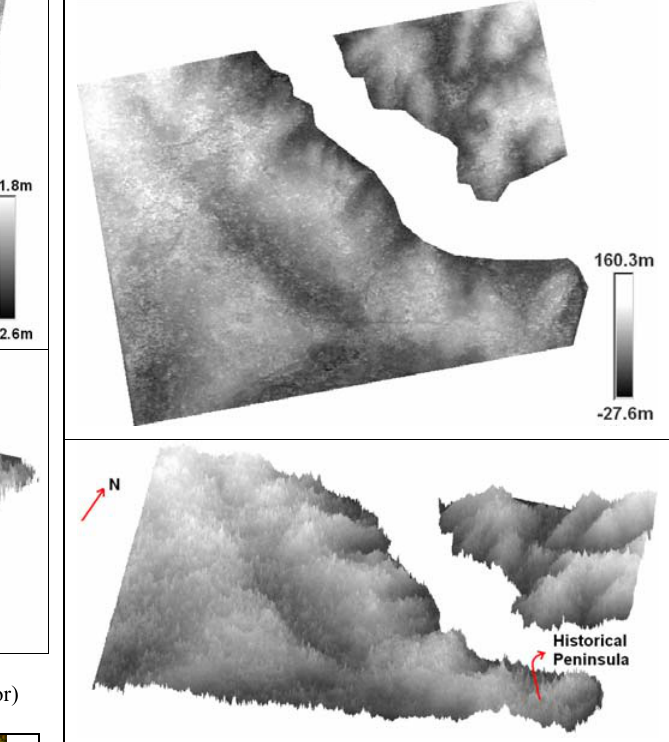
Figure 10. DEM of TSX HS InSAR data set and 3D visualization (3 m grid